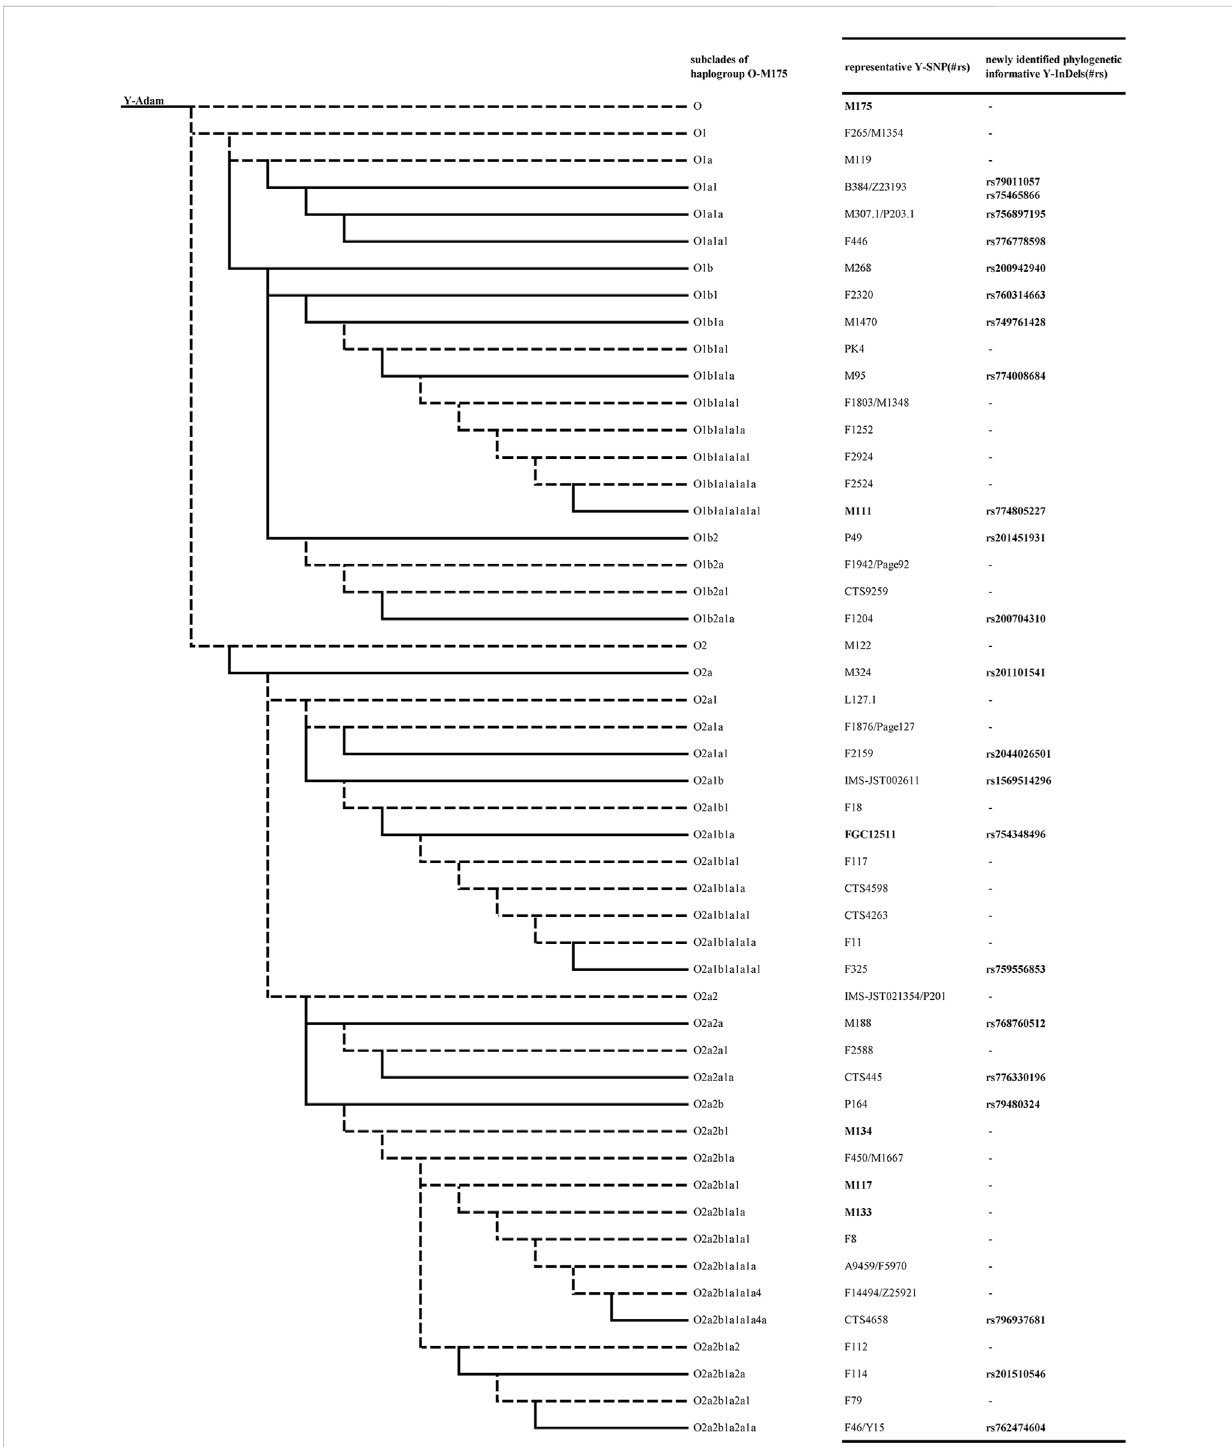
FIGURE 1 A phylogenetic tree constructed by phylogenetic informative Y-InDels with representative Y-SNPs of corresponding subclades. The dotted lines indicate haplogroups/sub-haplogroups which is not included in the current study. The bold fonts indicate Y-InDel loci.